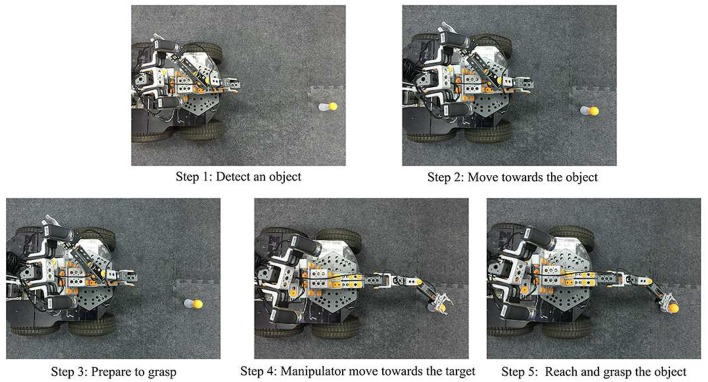
The procedure in complex game mode.